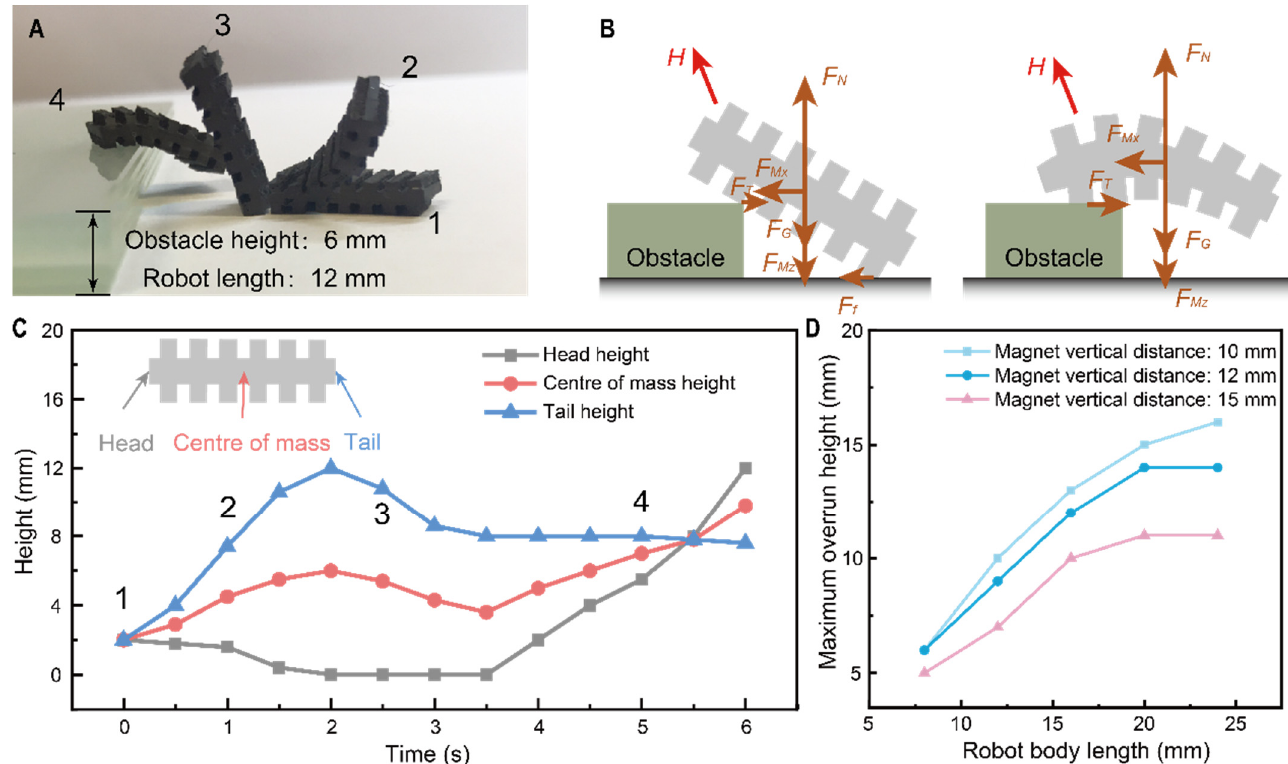
Figure 3. Soft robot overrunning capability based on tumbling motion. ( A ) Soft robot tumbling motion driven by rotating magnetic fields. The steps of the overturning movement are 1, 2, 3 and 4. ( B ) Analysis of forces in two tumbling states. In this figure, H means the internal pulling force, F Mx and F Mz are the magnetic pulling force along x and z direction respectively, F f refers the friction force from ground, F T refers the friction force from the obstacle and F N refers the support. ( C ) Changes in the height of head, tail, and center of gravity during the overturn. ( D ) Relationship between soft robot body length and maximum overturning capacity.